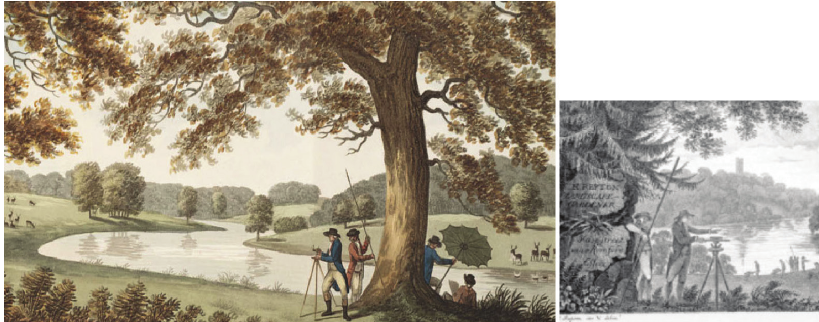
Figure 5. Humphry Repton, “recycling” parts of drawings as seen in trade card and a fragment of hand-colored aquatint, Sketches and Hints on Landscape Gardening (London: W. Bulmer and Co, 1794) (left). Plate XI “A View of the water, and some of the large oaks, at Welbeck” (right). Courtesy, the Winterthur Library: Printed Book and Periodical